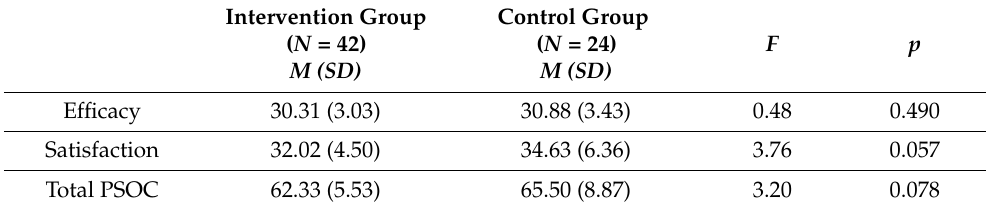
Table 1. Comparison of parental competences in the intervention and control groups.